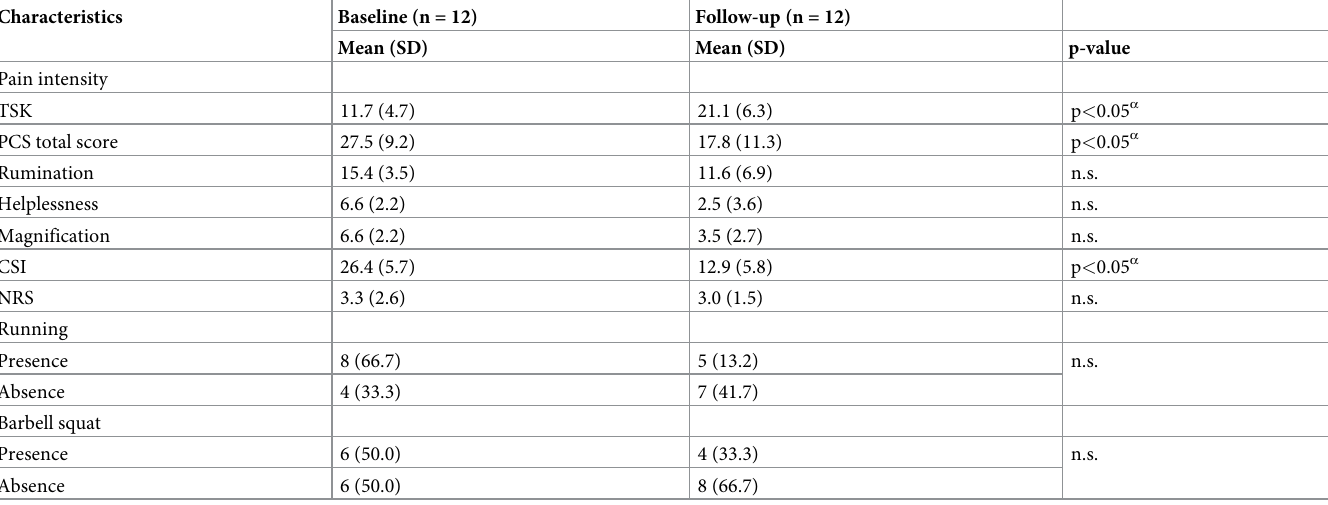
Table 4. A prospective cohort survey of characteristics for